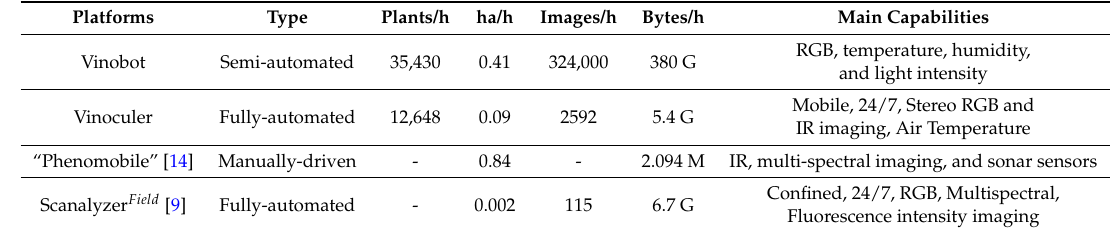
Table 3. Comparison between field-based systems that perform phenotyping of groups of plants. Platforms